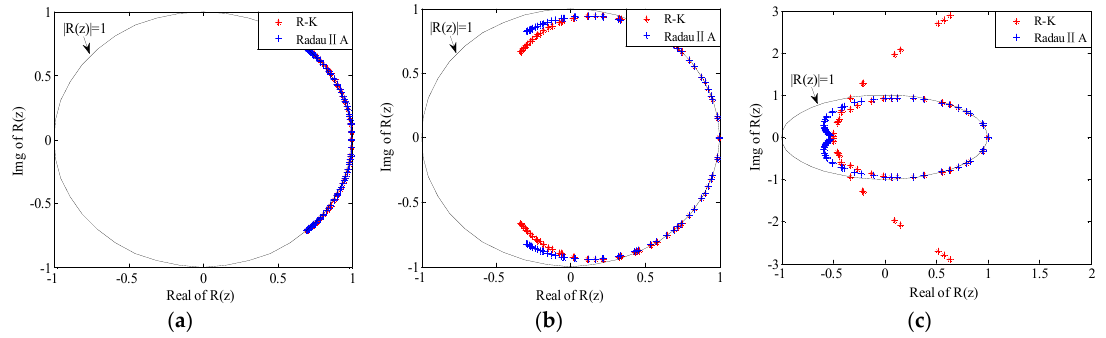
Figure 9. Stability analysis for RAECM with variable-time discretization between fourth-order R-K and RadauIIA: ( a ) dt = 0.02 s; ( b ) dt = 0.05 s; ( c ) dt = 0.1 s.